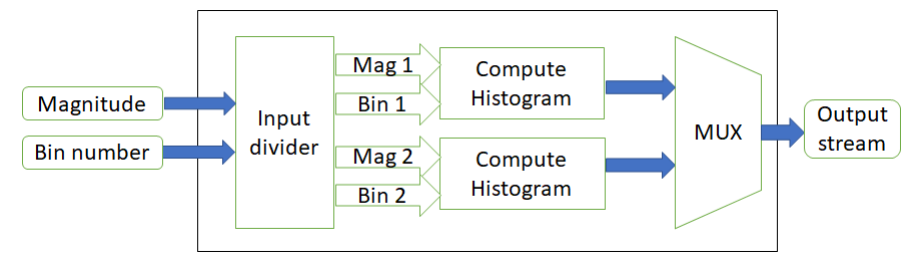
Figure 9. One-row histogram generation module.